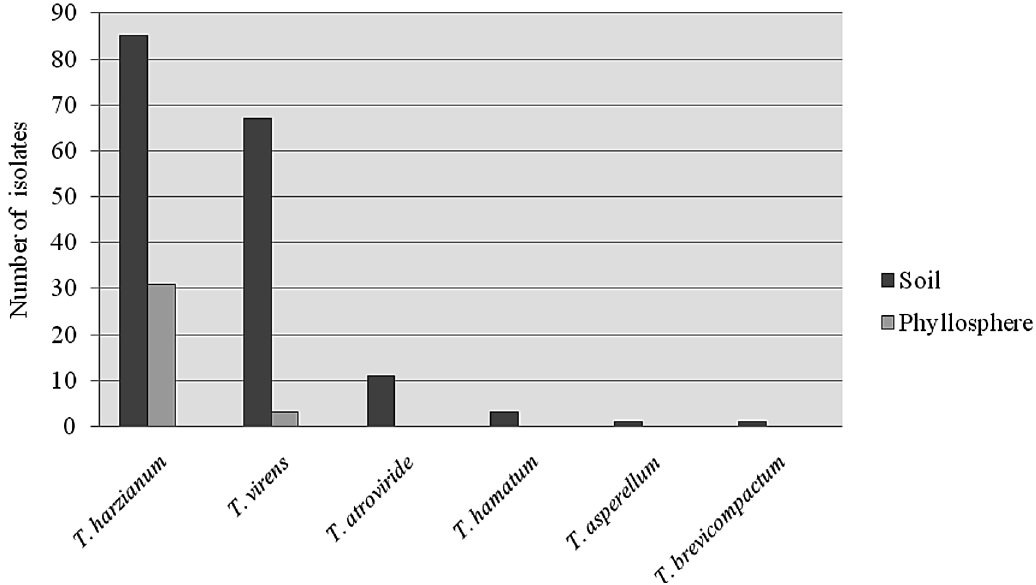
Figure 2. Proportional frequency of Trichoderma species isolated from rice fields in Mazandaran province, northern